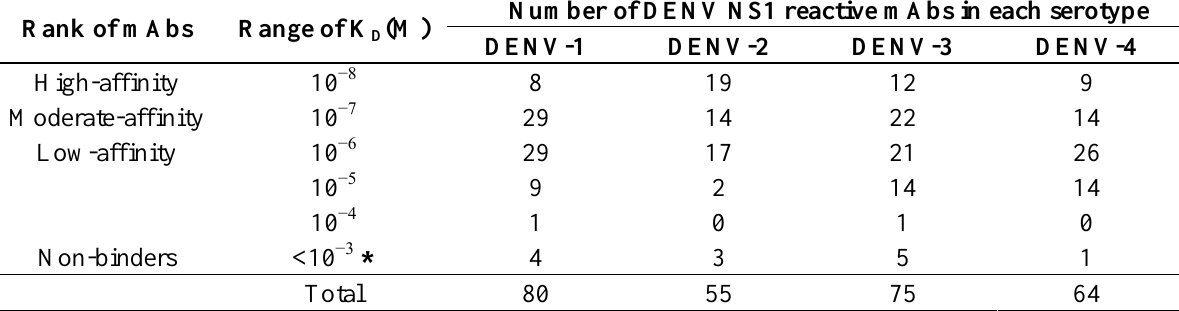
Table 2. The affinity range of DENV NS1 reactive mAbs measured by RWG ( * Low affinity